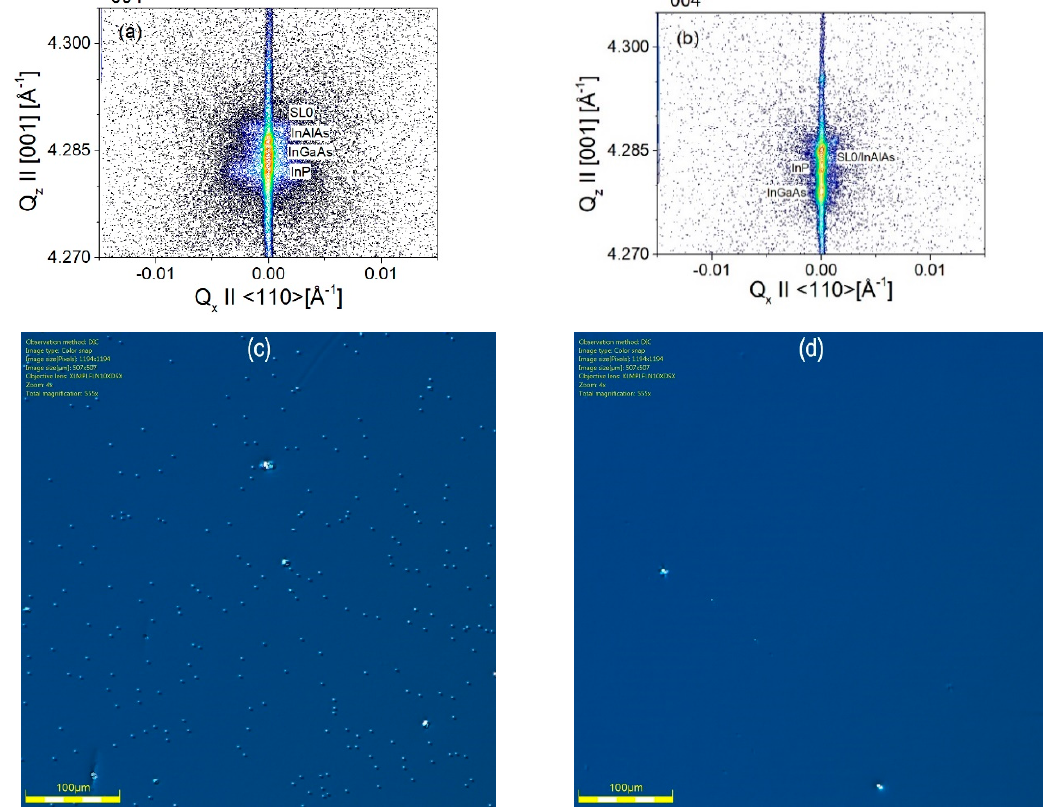
Figure 10. Reciprocal space map of X-ray intensity around 004 Bragg reflection for QCL sample grown at constant temperature T g = 520 ◦ C and V / III = 12 ( a ) and at the optimized growth technology ( b ). Surface morphology for sample grown at constant temperature T g = 520 ◦ C and V / III = 12 ( c ) and the one grown by optimized growth technology ( d ).